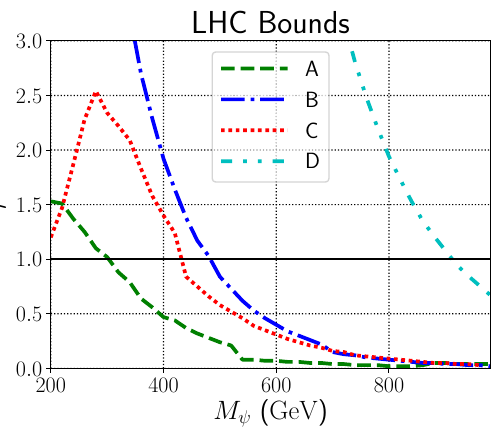
Figure 1. Exclusion limits for benchmark points A D with varying M ψ generated using − CheckMATE . The ordinate r is the ratio of predicted to observed signal events for the most con- straining analysis. Points above the r = 1 line are excluded. For benchmark point C , the initial increase in r for low M ψ is due to relaxation of the kinematic suppression of ψ decays to the heavier scalar